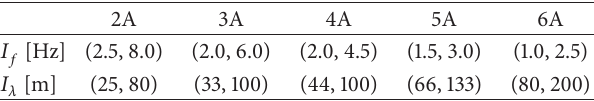
Table 3: Frequency intervals 𝐼 𝑓 and corresponding wavelength intervals 𝐼 𝜆 for different dimensions of the